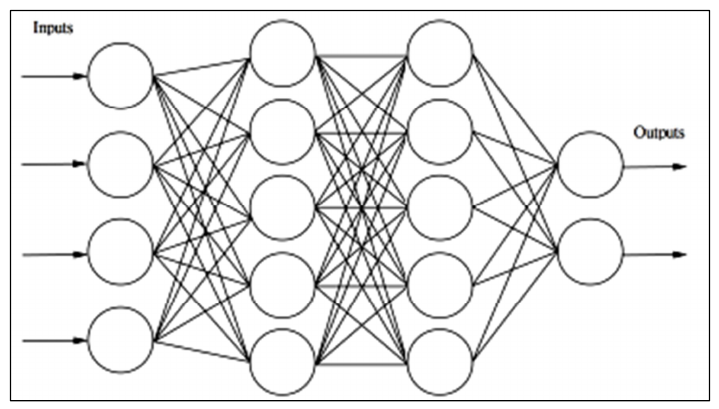
Figure 2 – Multi-layered feed forward